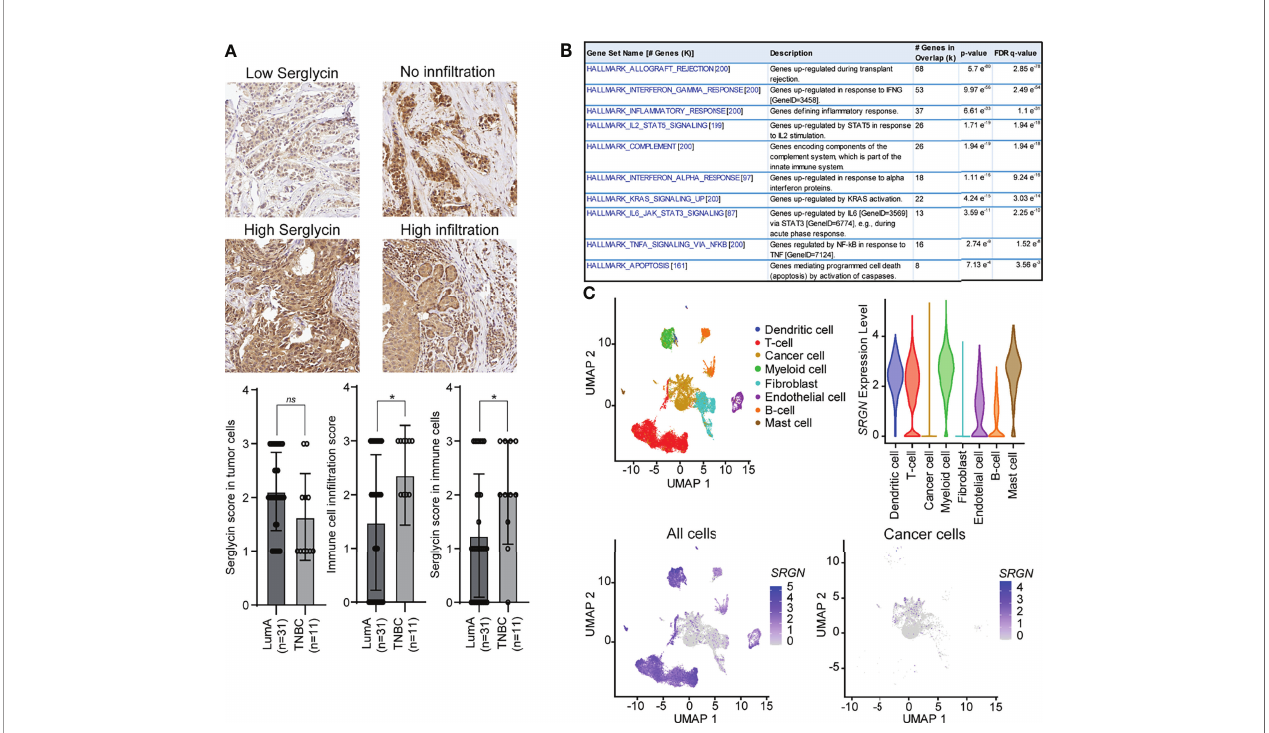
FIGURE 4 | Serglycin is expressed by non-neoplastic cells in breast tumor tissue. (A) Immune staining for serglycin in breast cancer patients de fi ned as either luminal A (LumA) or triple negative breast cancer (TNBC). Images representing low (score 1) and high (score 3) serglycin expression in cancer cells, and no (score 0) or high immune cell in fi ltration (score 3) are included. Bar plots includes quanti fi cation of expression of serglycin in either tumor cells or immune cells as well as quanti fi cation of immune in fi ltration in the tumor tissue. Error bars represent semi-standard deviation. (B) Gene set enrichment analysis for genes that show a high correlation with SRGN expression in patients with the basal-like subtype from the TCGA cohort. (C) SRGN expression in single cell RNA-Seq data including 18 patients with different subtypes. Top left: Visualization of the different cell types in the UMAP plot. Top right: SRGN expression visualized as violine plots per cell type. Bottom left: UMAP plot of SRGN expression in all cell types. Bottom right: UMAP plot of SRGN expression in only cancer cells. (*p ≤ 0.05; ns, not signi fi